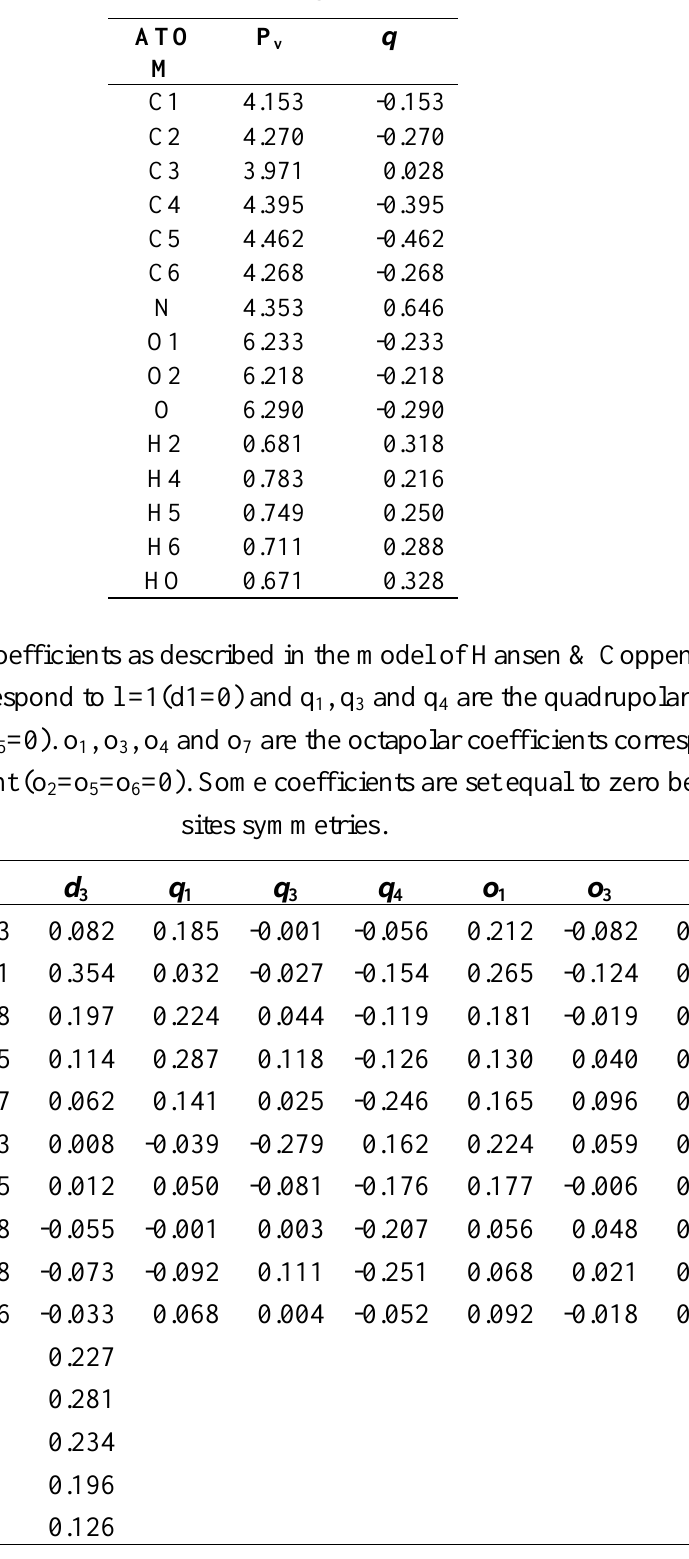
Table 2. Net atomic charge in m-Nitrophenol